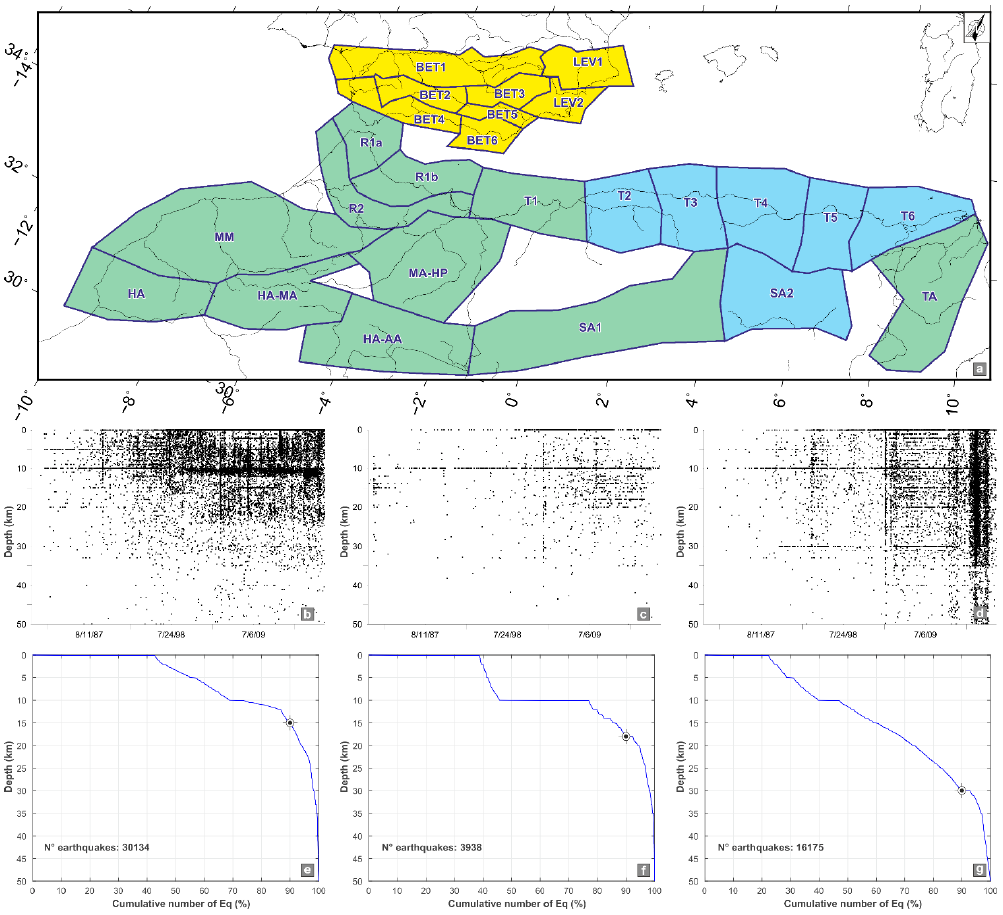
Figure A1. ( a ) Seismic source zones subdivision into three main regions. In yellow, the Betics seismogenic sources (BET1, BET2, BET3, BET4, BET5, BET6, LEV1, and LEV2); in green the Rif—western Atlas seismogenic sources (R1a, R1b, R2, T1, MM, HA, HA-MA, HA-AA, SA1, MA-HP, and TA); in light-blue the Tell Atlas seismogenic sources (T2, T3, T4, T5, T6, and SA2). ( b ) Depth distribution—time plot of the Betics seismogenic sources. ( c ) Depth distribution—time plot of the Tell Atlas seismogenic sources. ( d ) Depth distribution—time plot of the Rif—western Atlas seismogenic sources. ( e ) Cumulative frequency plots of depth distribution of earthquakes; 90% of events occur at depths less than 15 km for the Betics main region. ( f ) Cumulative frequency plots of depth distribution of earthquakes; 90% of events occur at depths less than 18 km for the Tell Atlas main region. ( g ) Cumulative frequency plots of depth distribution of earthquakes; 90% of events occur at depths less than 30 km for the Rif - western Atlas main region.